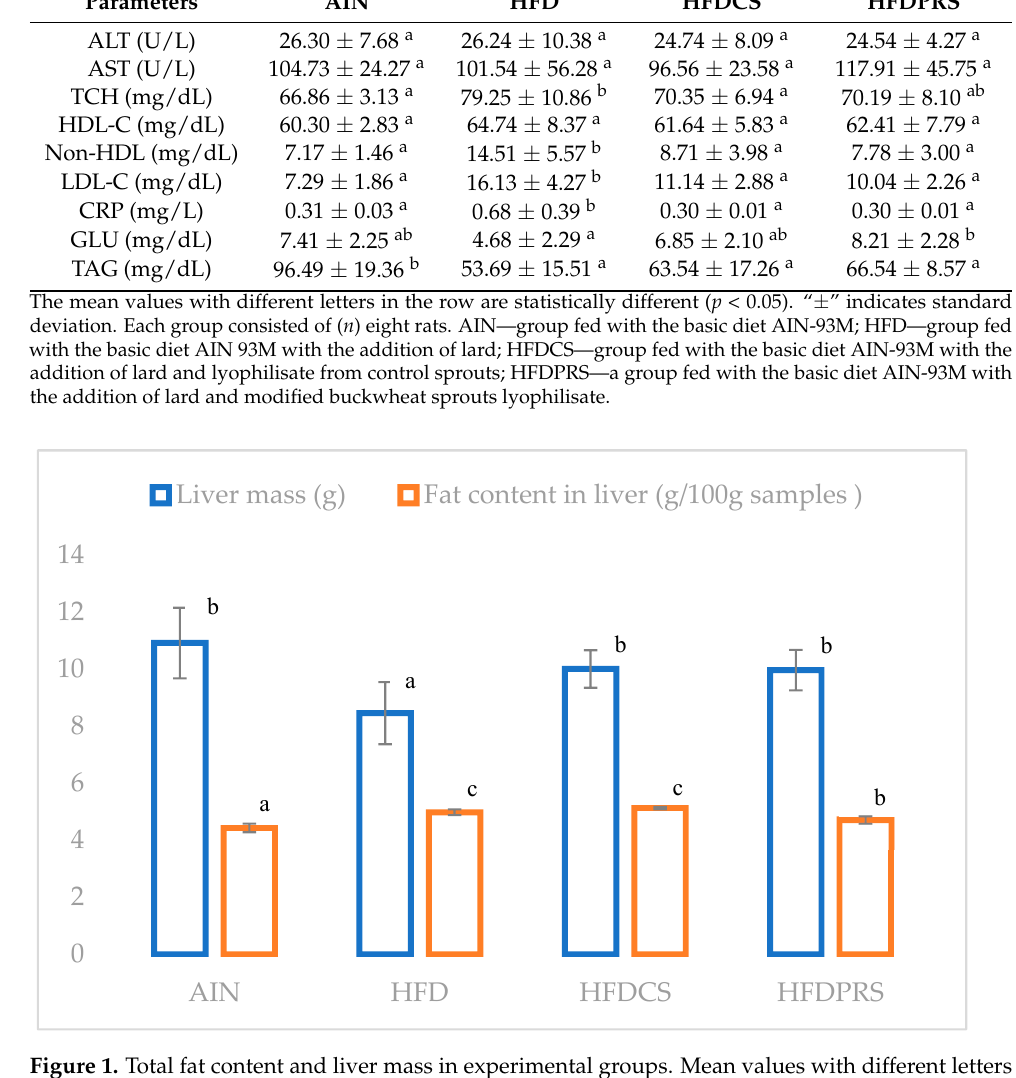
Table 2. Influence of the diets with or without probiotic-rich sprouts on biochemical parameters in rats. The mean values with different letters in the row are statistically different ( p < 0.05). “±” indicates standard deviation. Each group consisted of ( n ) eight rats. AIN—group fed with the basic diet AIN- Parameters AIN HFD HFDCS HFDPRS 93M; HFD—group fed with the basic diet AIN 93M with the addition of lard; HFDCS—group fed ALT (U/L) 26.30 ± 7.68 a with the basic diet AIN-93M with the addition of lard and lyophilisate from control sprouts; HFDPRS—a group fed with the basic diet AIN-93M with the addition of lard and modified buck- wheat sprouts lyophilisate.